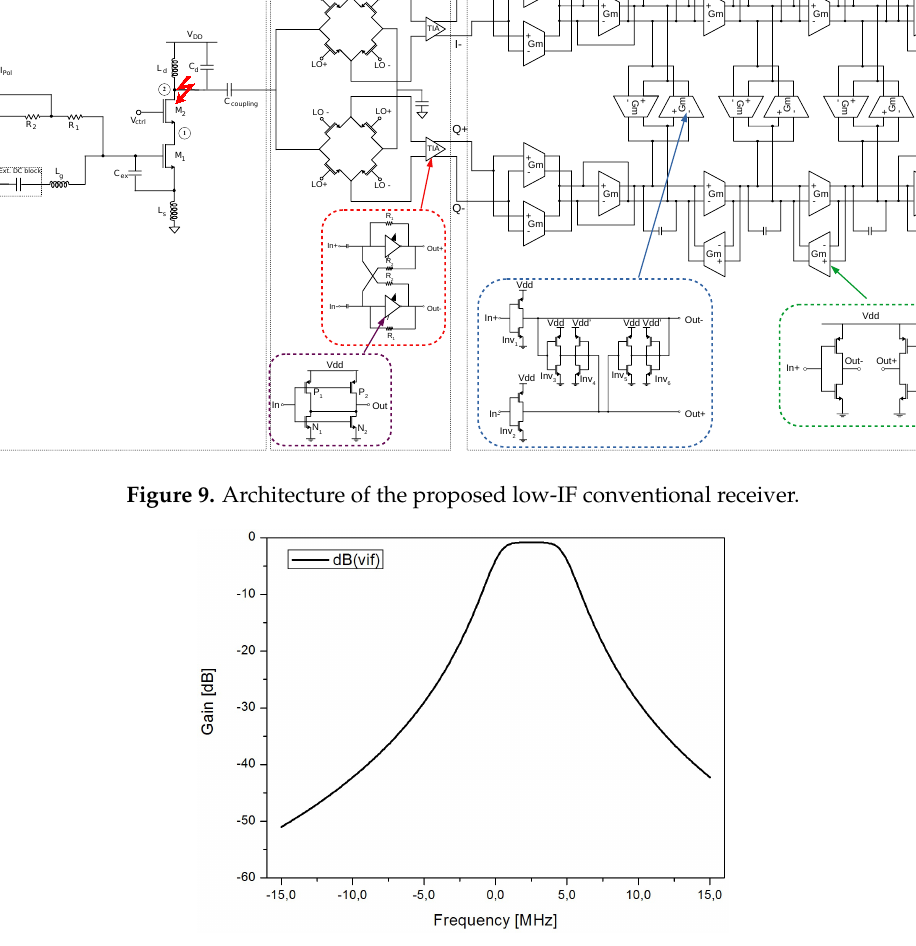
Figure 10. Frequency response of the complex